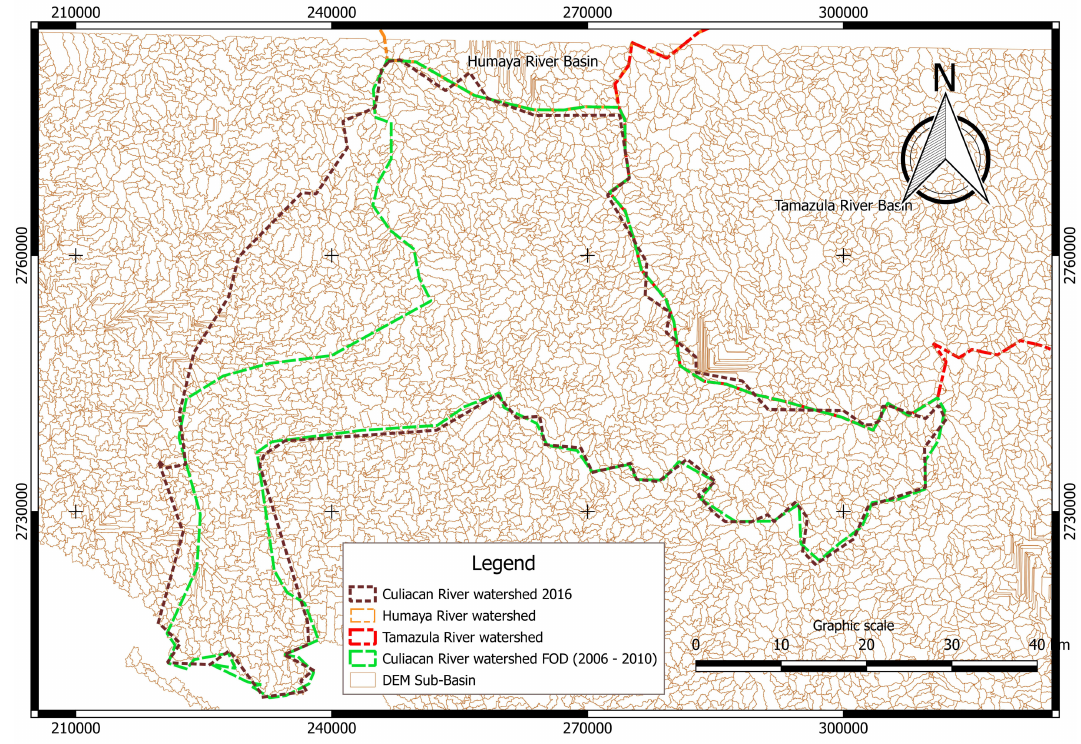
Figure 5. Comparison between drainage divides generated with a GIS based on DEMs obtained from INEGI (2017b) and the official watershed delineation published by CONAGUA